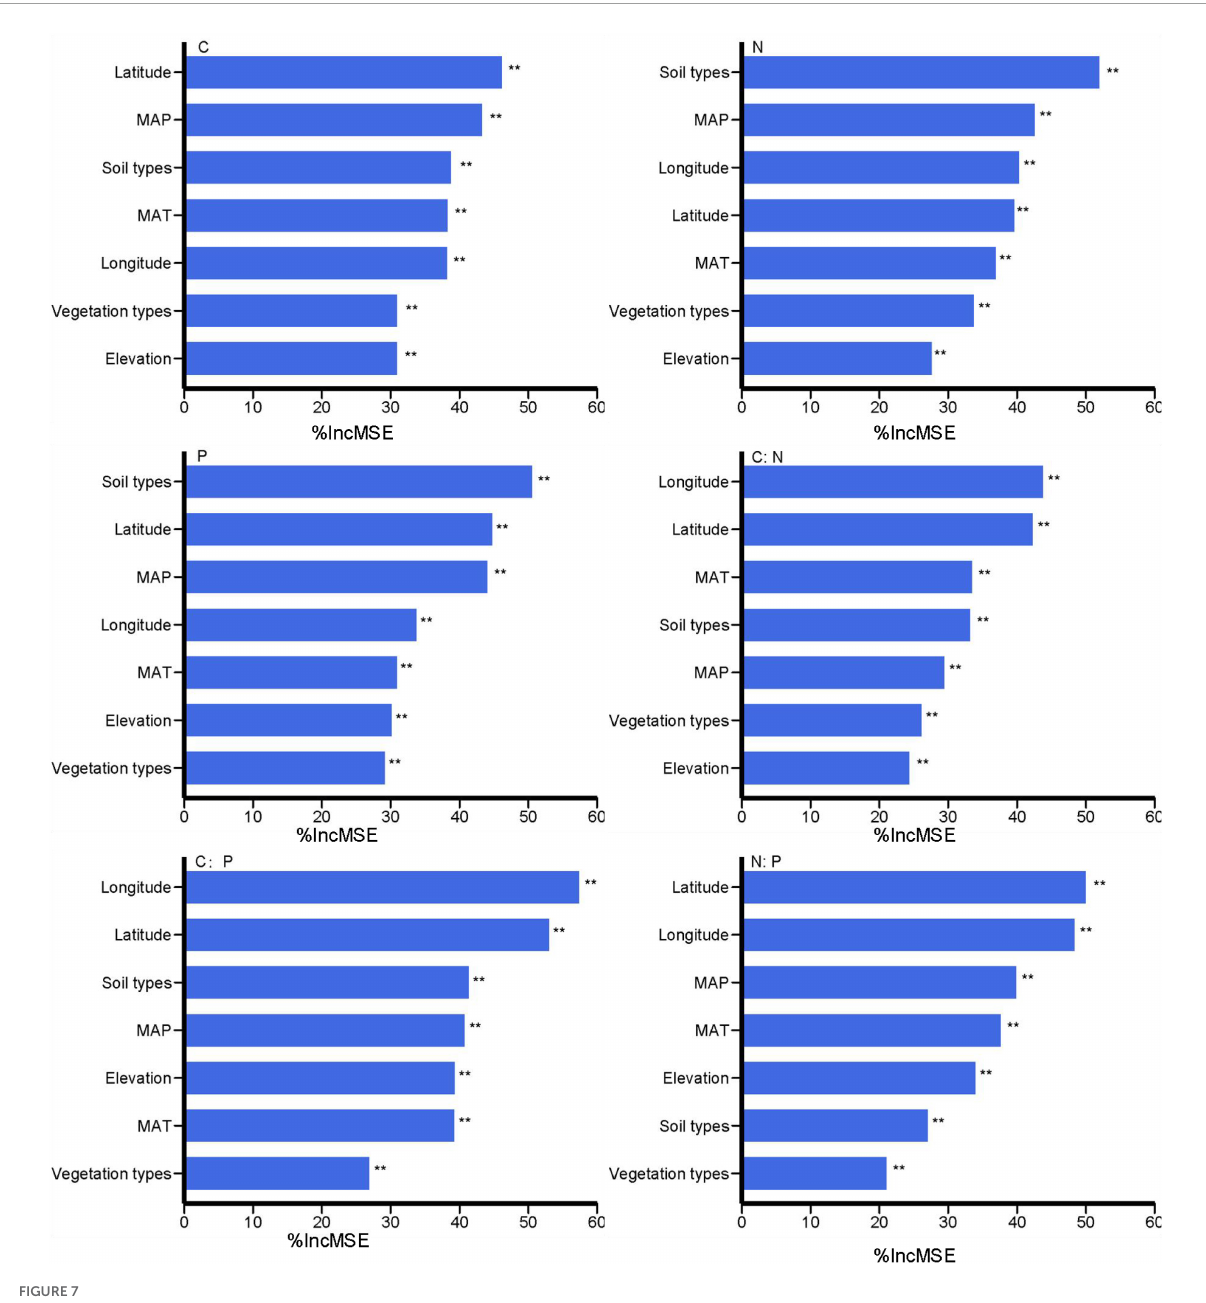
(4.2) for China’s topsoil (Cleveland and Liptzin, 2007; Tian et al.,